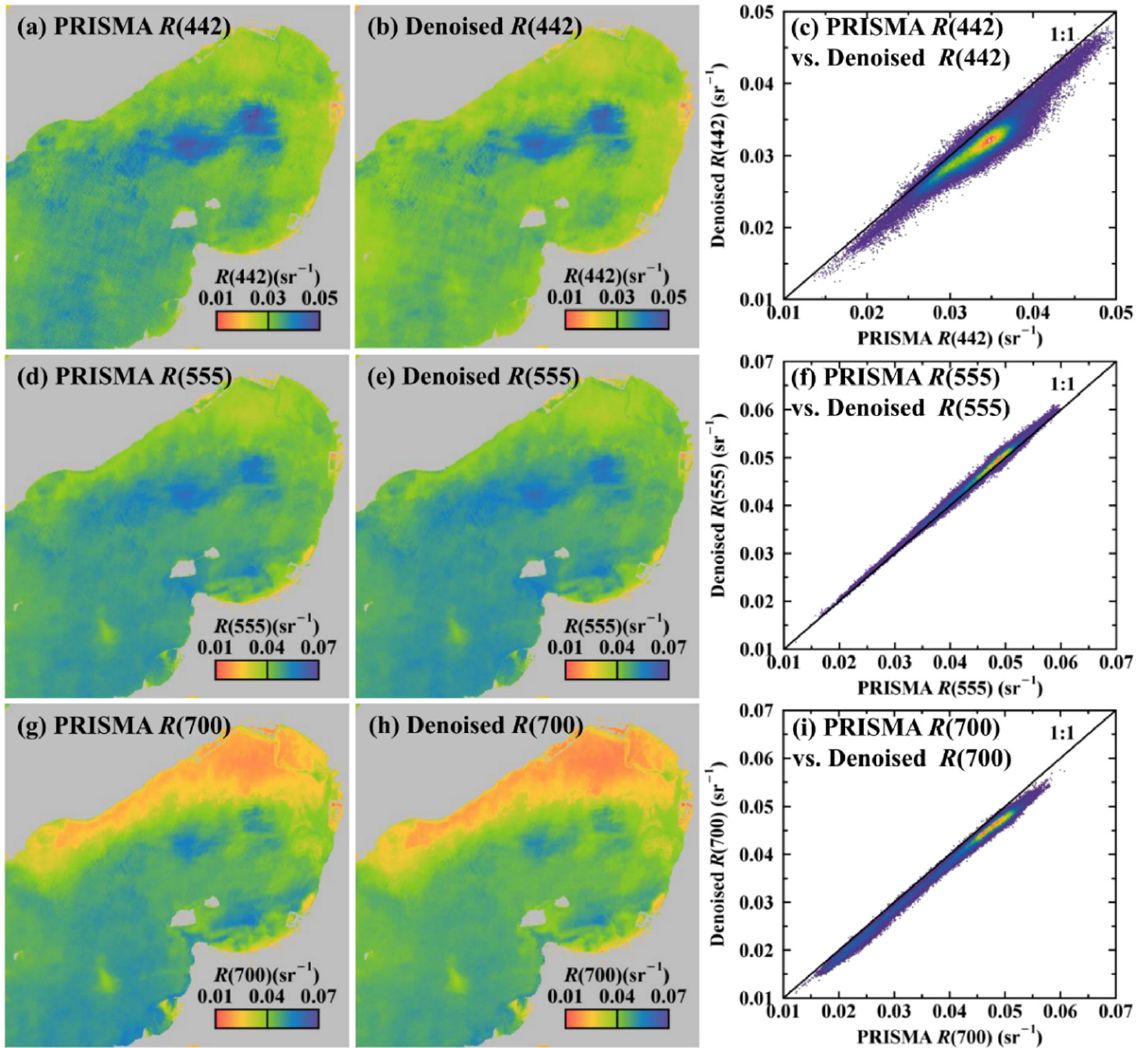
Figure 10. PRISMA and SR denoised images of band 442 nm ( a , b ); 555 nm ( d , e ); and 700 nm ( g , h ); and the scatter plots of original and denoised images of ( c ) 442 nm; ( f ) 555 nm; and ( i ) 700 nm.